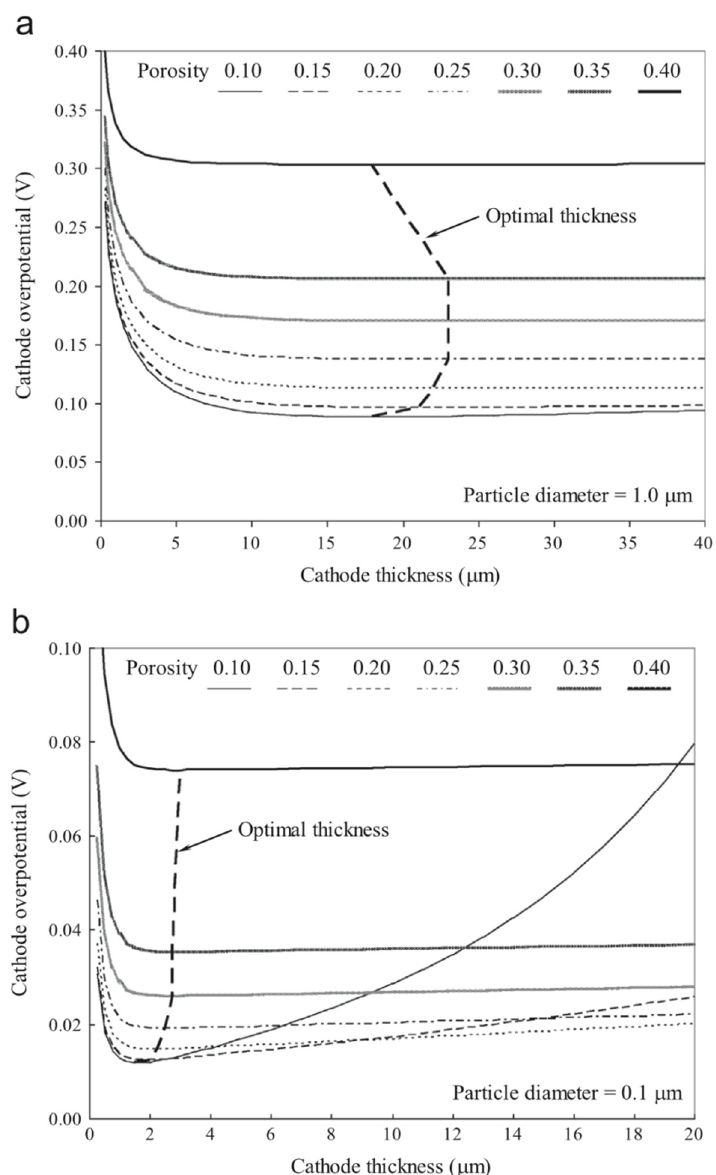
Figure 13. Cathodic overpotential as a function of thickness for different porosities: ( a ) particle size equal to 1.0 µ m, ( b ) particle size equal to 0.1 µ m. In both the simulations, cathodes with equal volume fractions of LSM and YSZ were considered, while the temperature was set to 800 °C (figure reprinted from Bertei et al. [126] Copyright (2013), with permission from Elsevier).